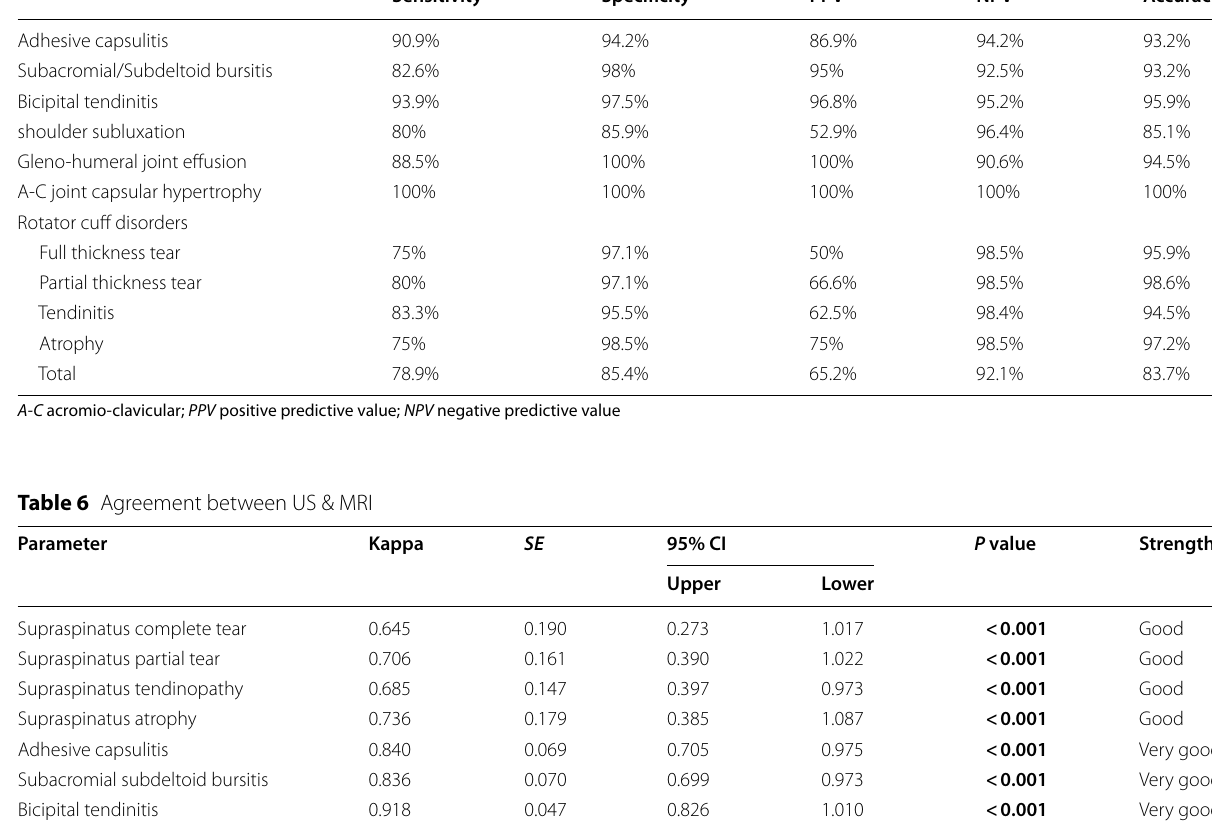
Table 5 Shoulder ultrasound sensitivity, specificity, PPV, NPV and accuracy in relation to shoulder MRI